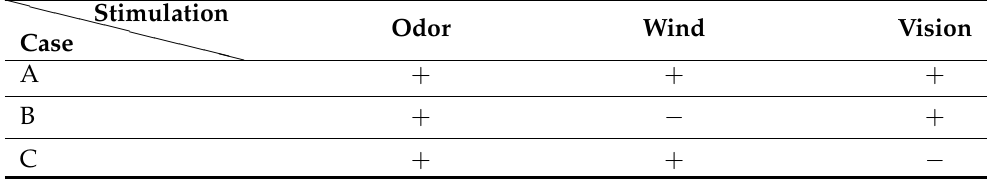
Table 1. Conditions for VR experiment. The “ + ” indicates that the detection direction of the agent and the direction of stimulus presentation to the silk moth is the same. The “ − ” indicates that the detection direction of the agent and the direction of stimulus presentation to the silk moth are exactly